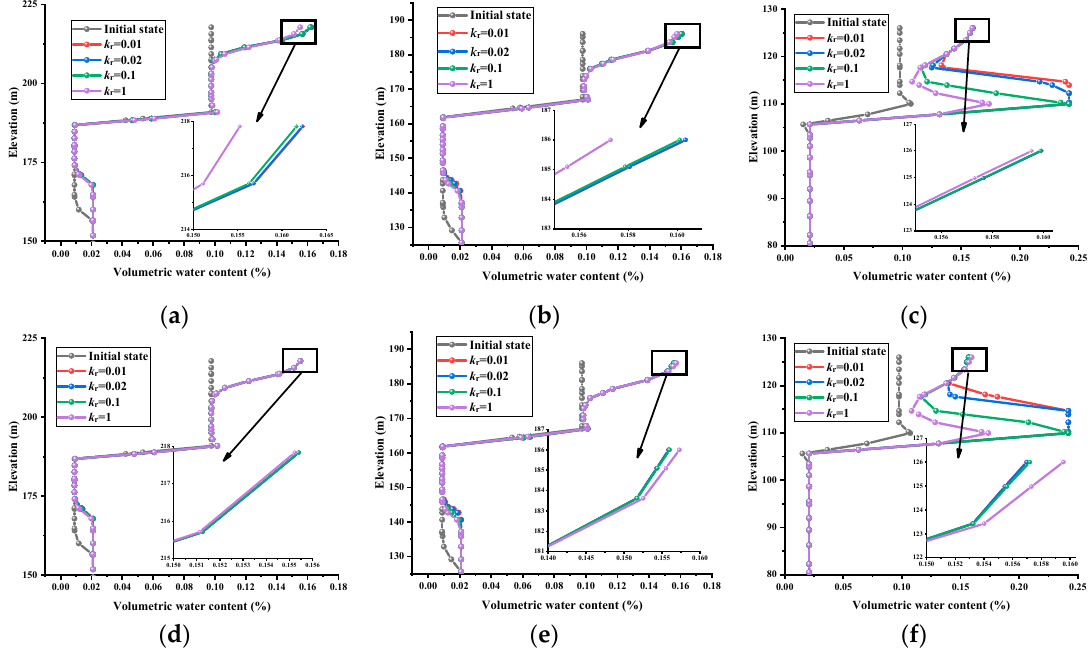
Figure 9. Volumetric water content levels at di ff erent positions on the layered rock slope under di ff erent k r values with α = 50 ◦ and α = 70 ◦ : ( a ) Top of the slope with α = 50 ◦ ; ( b ) Middle of the slope with α = 50 ◦ ; ( c ) Bottom of the slope with α = 50 ◦ ( d ) Top of the slope with α = 70 ◦ ; ( e ) Middle of the slope with α = 70 ◦ ; ( f ) Bottom of the slope with α = 70 ◦